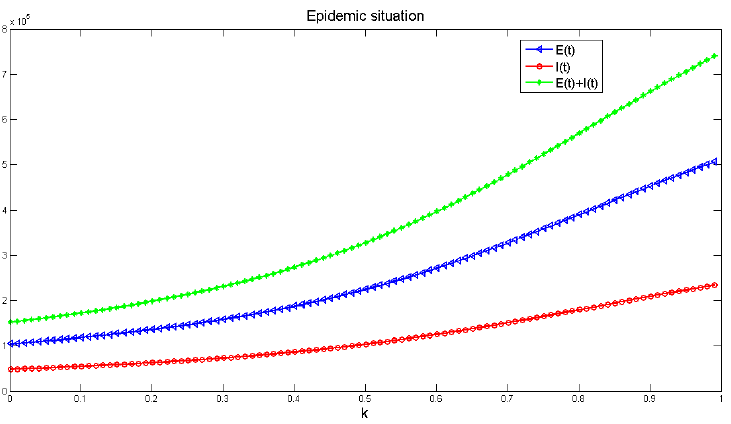
Figure 9. The effect of the ratio k on the infection number of E ( t ), I ( t ) and R ( t ) from the consciously susceptible to the unconsciously susceptible population.